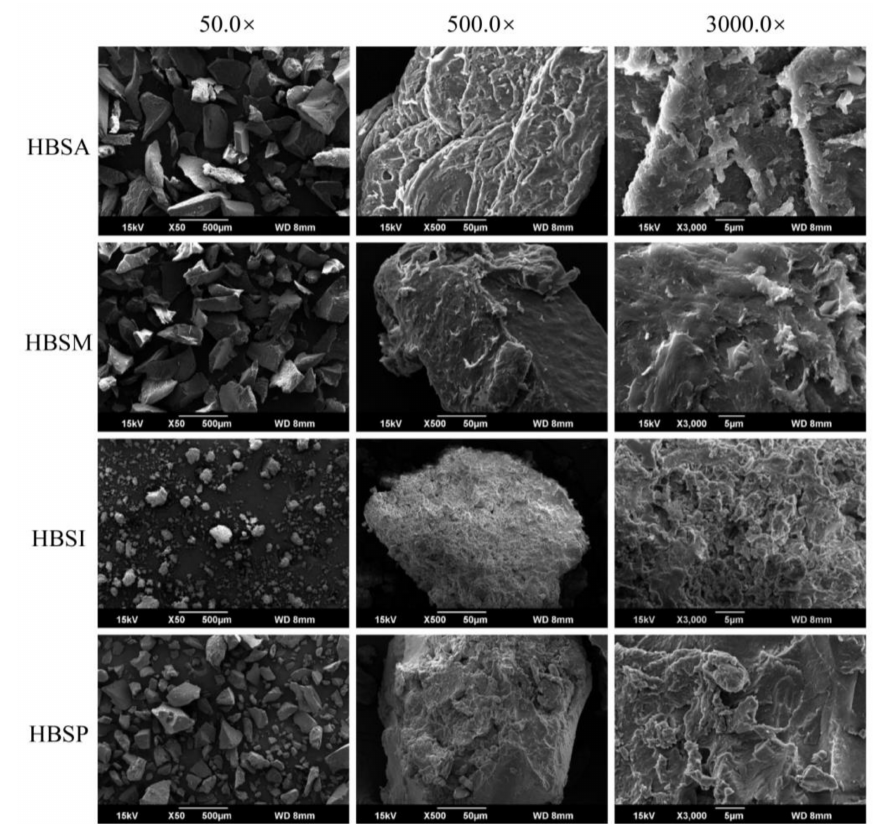
Figure 1. The morphological properties of HBSA, HBSM, HBSI, and